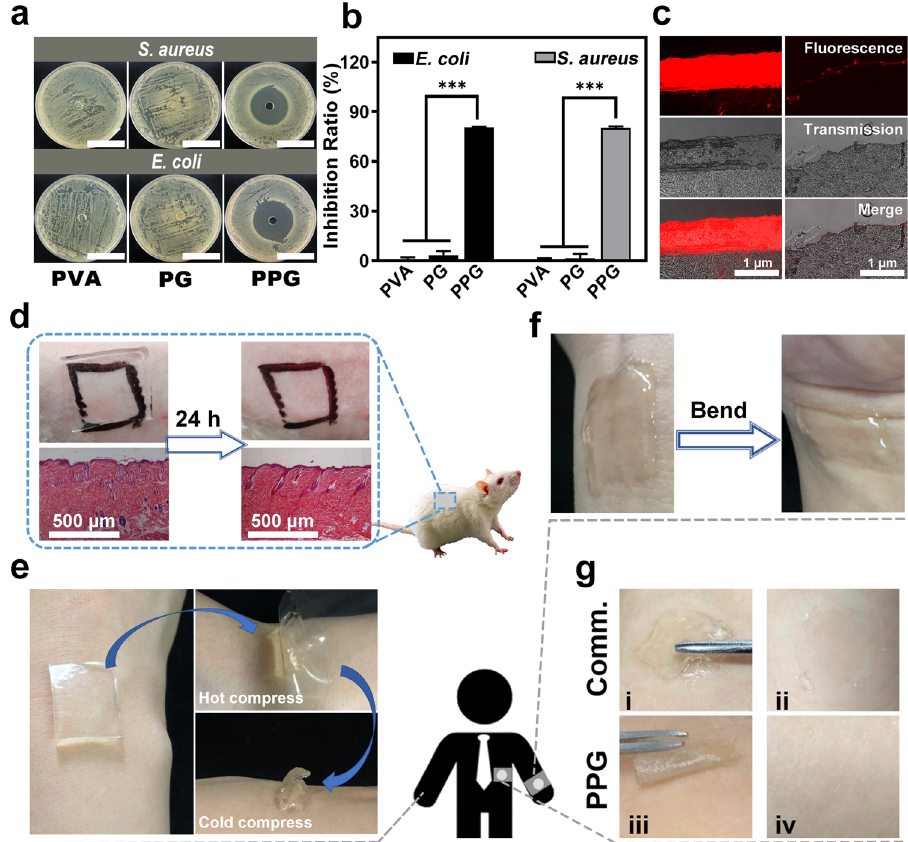
Fig. 3 Biocompatibility of PPG hydrogel. a , b Inhibition zones and inhibition ratios of hydrogels to E. coli and S. aureus (scale bar: 2 cm, P *** < 0.001). Error bars represent the standard deviation ( n = 3). c Fluorescence intensity of fl uorescence-labeled PPG hydrogel (left) and residual hydrogel (right) on pigskin. d Photograph and H&E staining of PPG hydrogel bonded on the back skin of SD rats before and after 24 h. e Photographs of PPG hydrogel adhering to and peeling off from skin. f Adaptive ability of PPG hydrogel to skin. g Photographs of commercial hydrogel (i, ii) and PPG hydrogel (iii, iv) peeled off from the human skin after adhering for 24